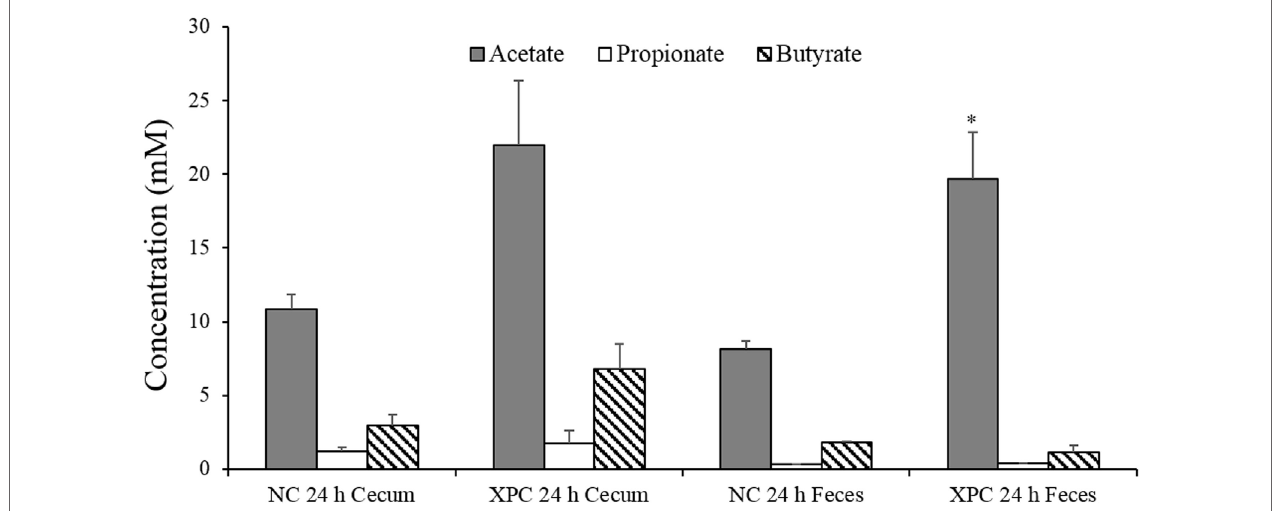
FigUre 5 | short chain fatty acid analysis of 24 h anaerobic cultures containing 6-week-old broiler cecal contents or feces with and without 1% fermentation metabolites of Original XPc . Bars and brackets represent the mean and SE of three biological replicates (chickens). Asterisk indicates significant difference ( P < 0.05) from corresponding negative control